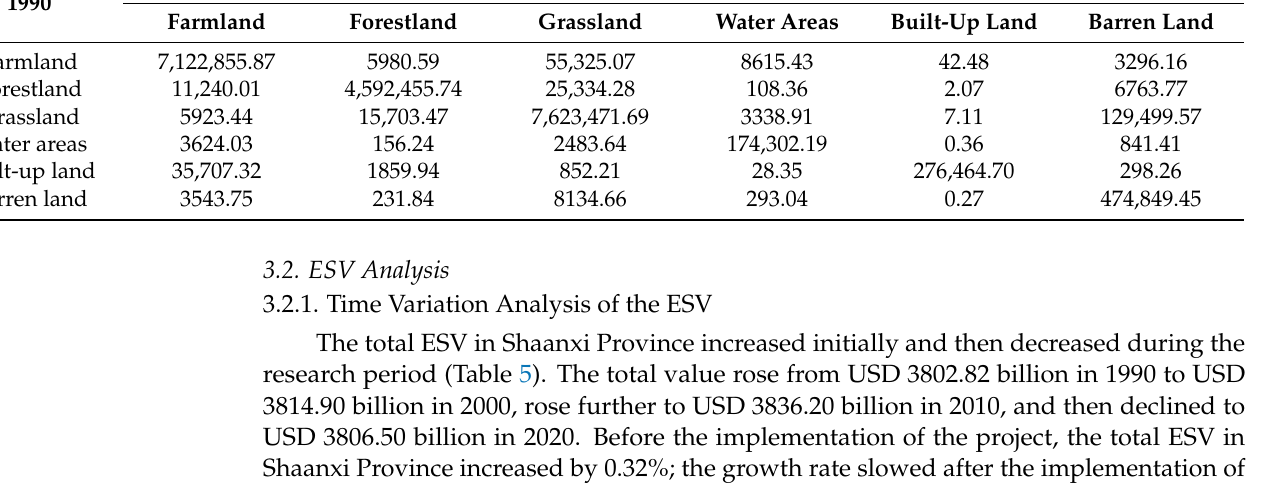
Table 3. Land-use transfer matrix of Shaanxi Province from 1990 to 2000.